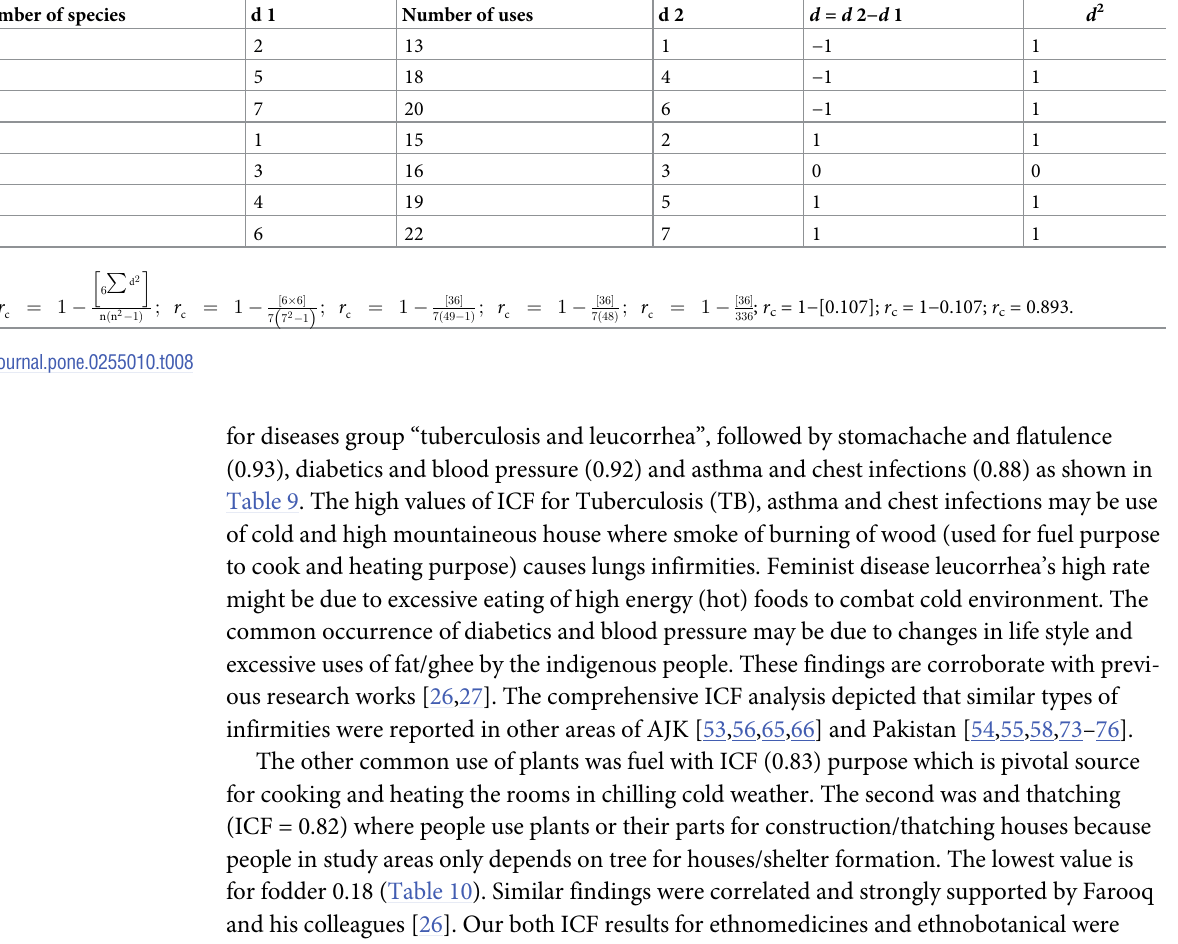
Table 8. Spearman correlation for female informants from Dawarian and Rati Gali, AJK, Pakistan. Age Number of